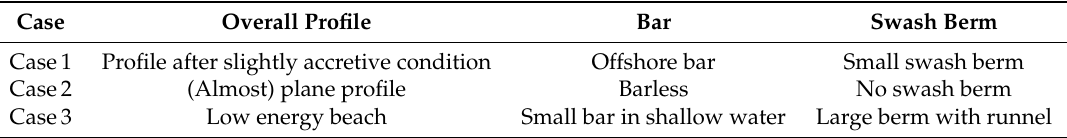
Table 4. Initial beach morphologies of the three